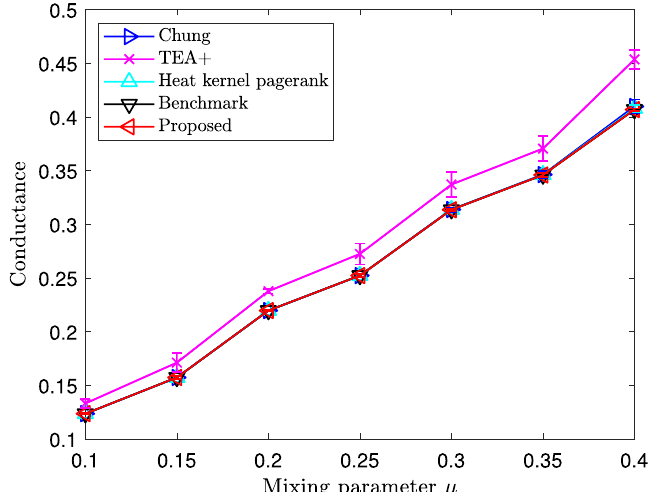
Figure 3. Average conductance values of local clusters estimated by performing sweeps on different heat kernel PageRank vectors in the Lancichinetti–Fortunato–Radicchi benchmark. Vertical error bars represent standard